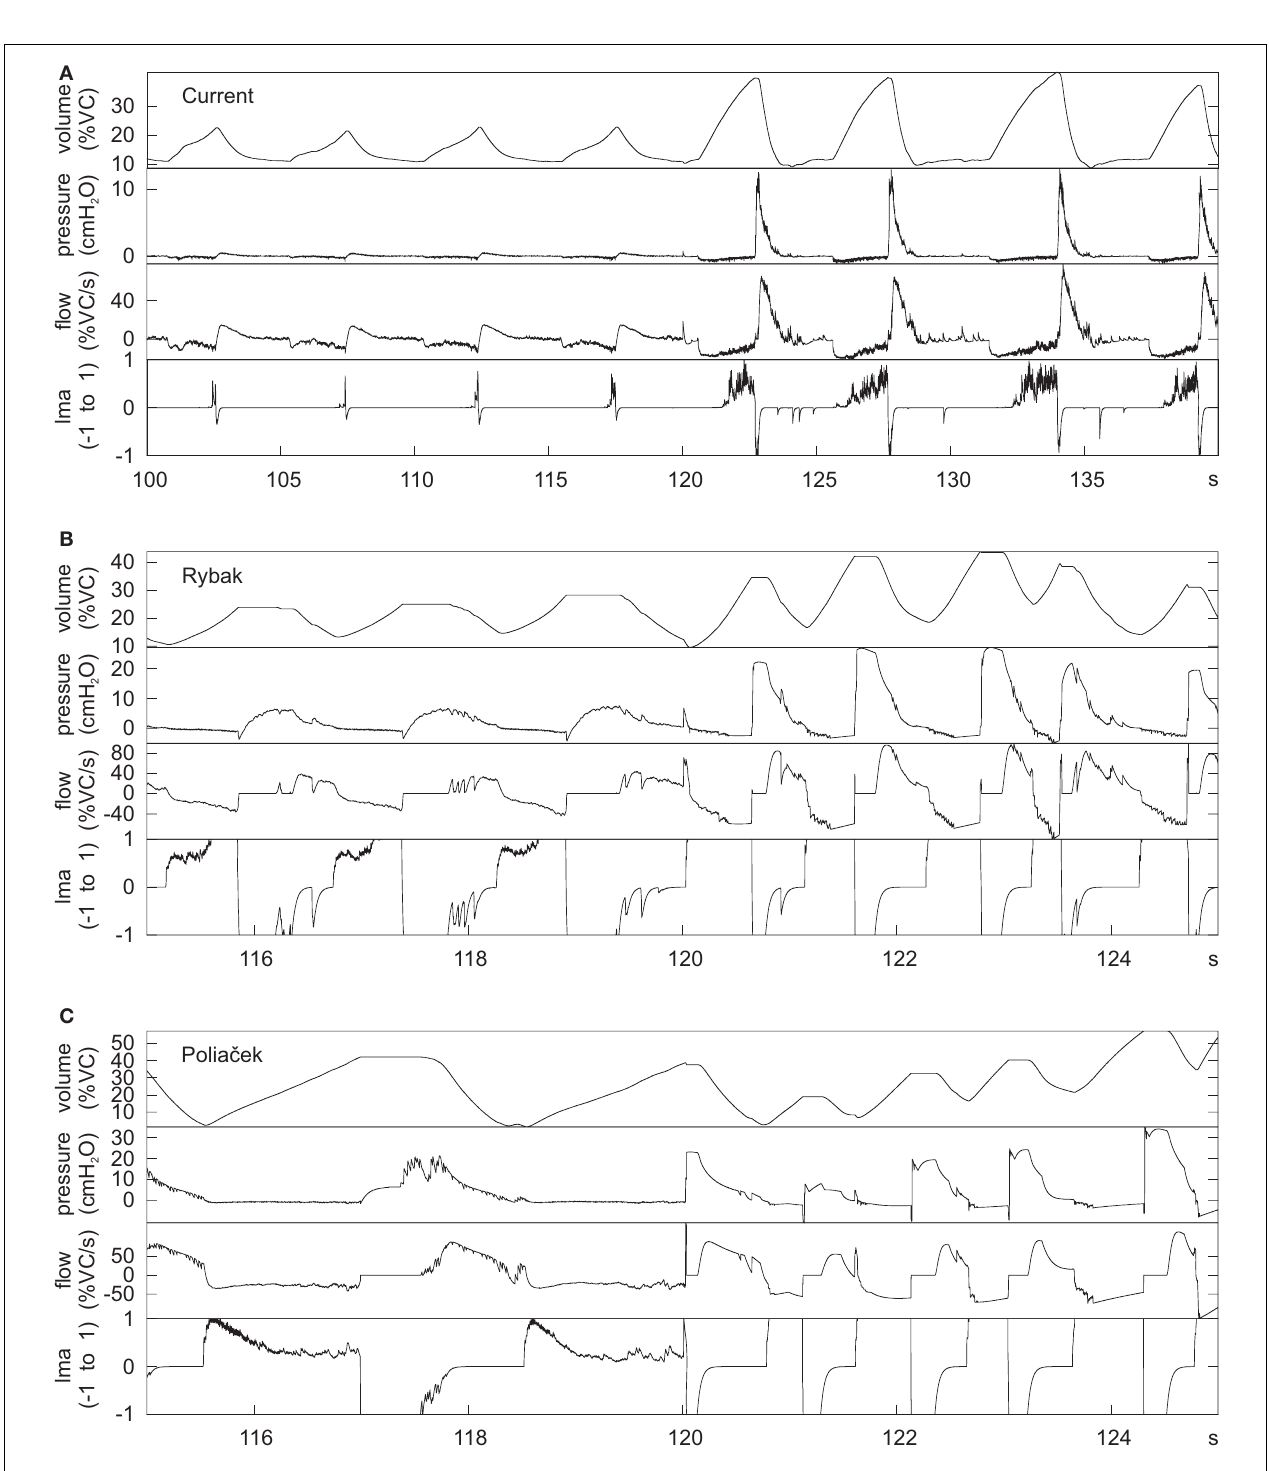
flow, and laryngeal muscle activation (lma).The value of lma is 1 for a maximally open glottis, 0 for the resting diameter, and − 1 for a closed glottis. The first few cycles are eupneic cycles, and the rest are coughs.The time scale is different for the current model because it was designed with slower cycles to match human